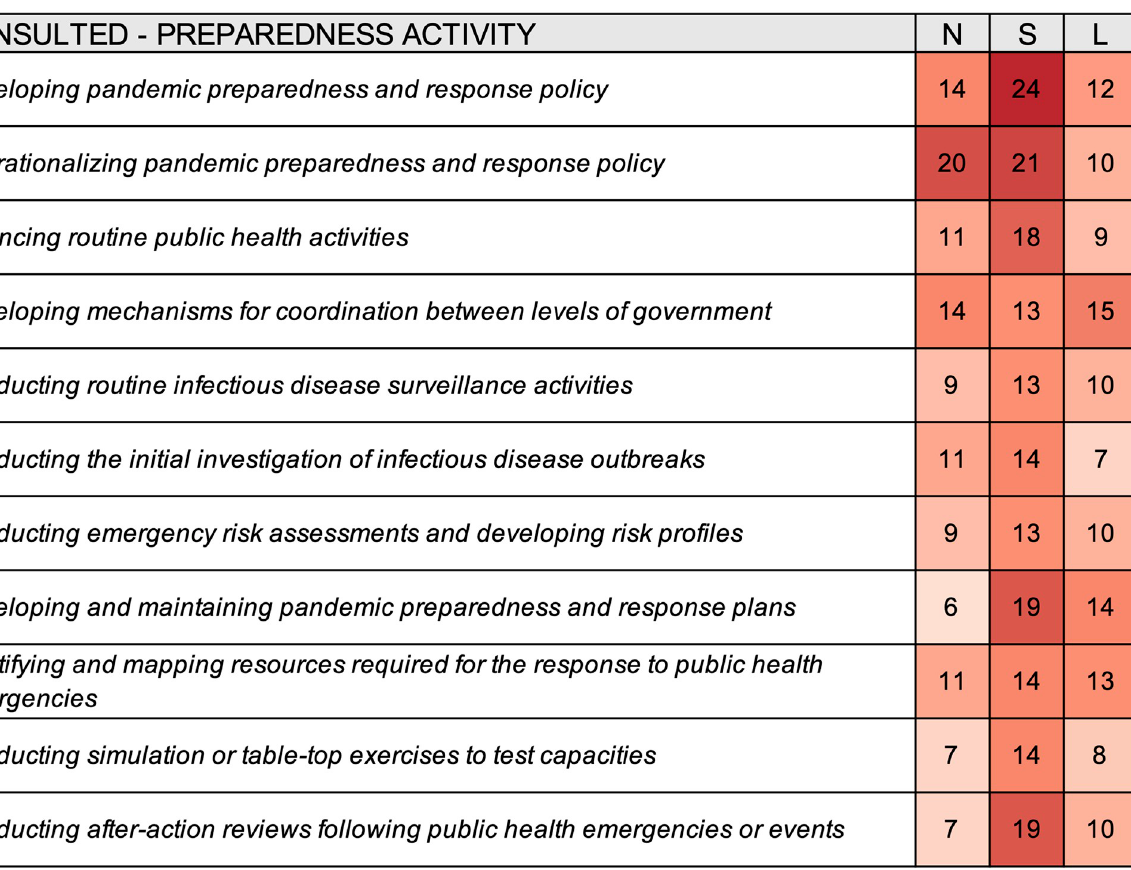
Fig 4. Heat map summarizing consultation for select preparedness activities for different levels of government according to survey responses from thirty-three cities. N–National, S–Subnational, L–Local.